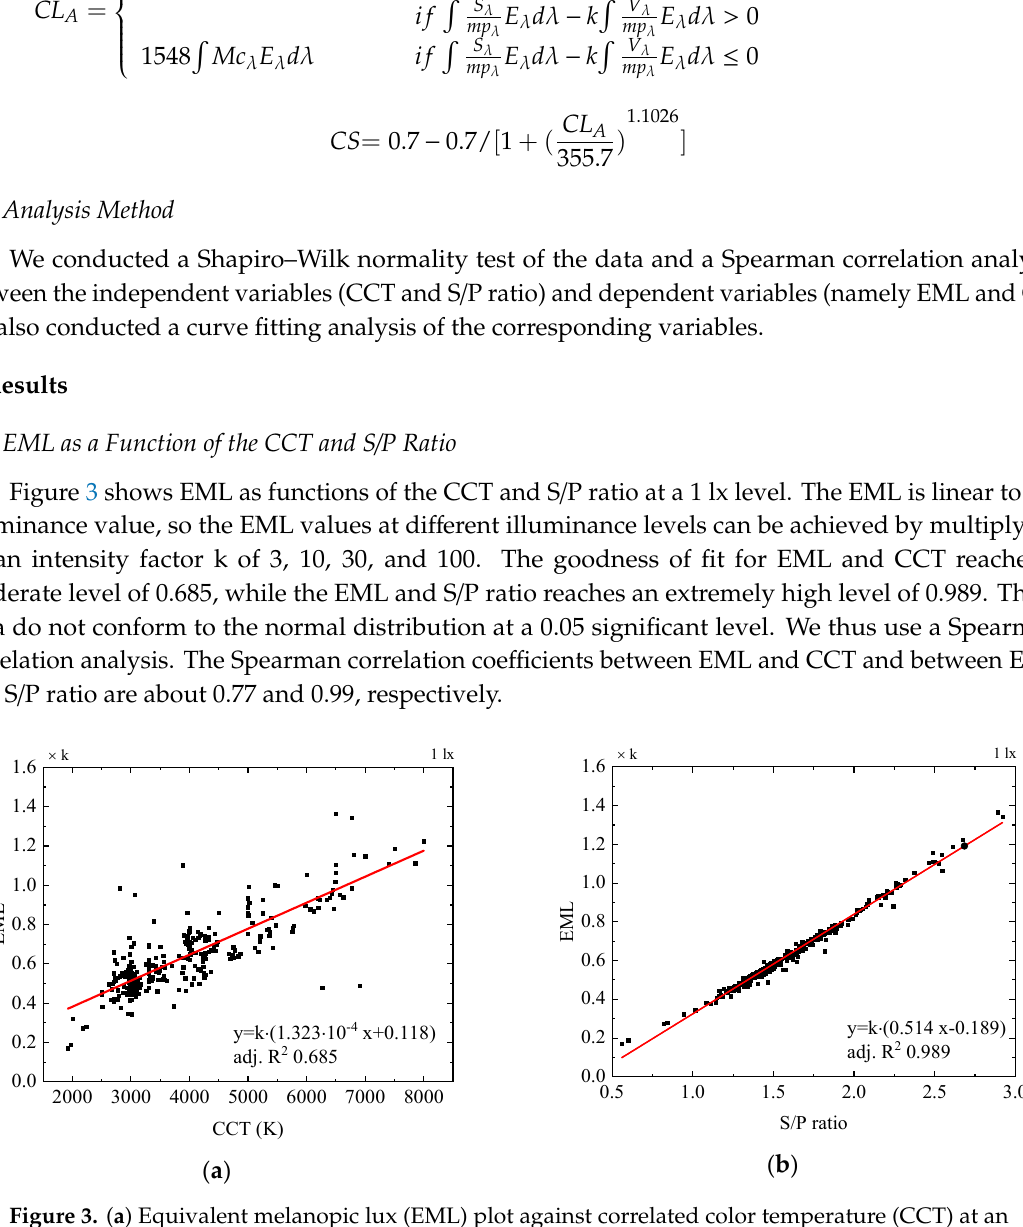
Figure 3. ( a ) Equivalent melanopic lux (EML) plot against correlated color temperature (CCT) at an illuminance value of 1 lx. In the graph, x represents CCT, y represents EML, and k is the adjusting coefficient equal to the illuminance level, e.g., 1 at a 1 lx level. ( b ) EML plot against the S/P ratio at an illuminance of 1 lx.